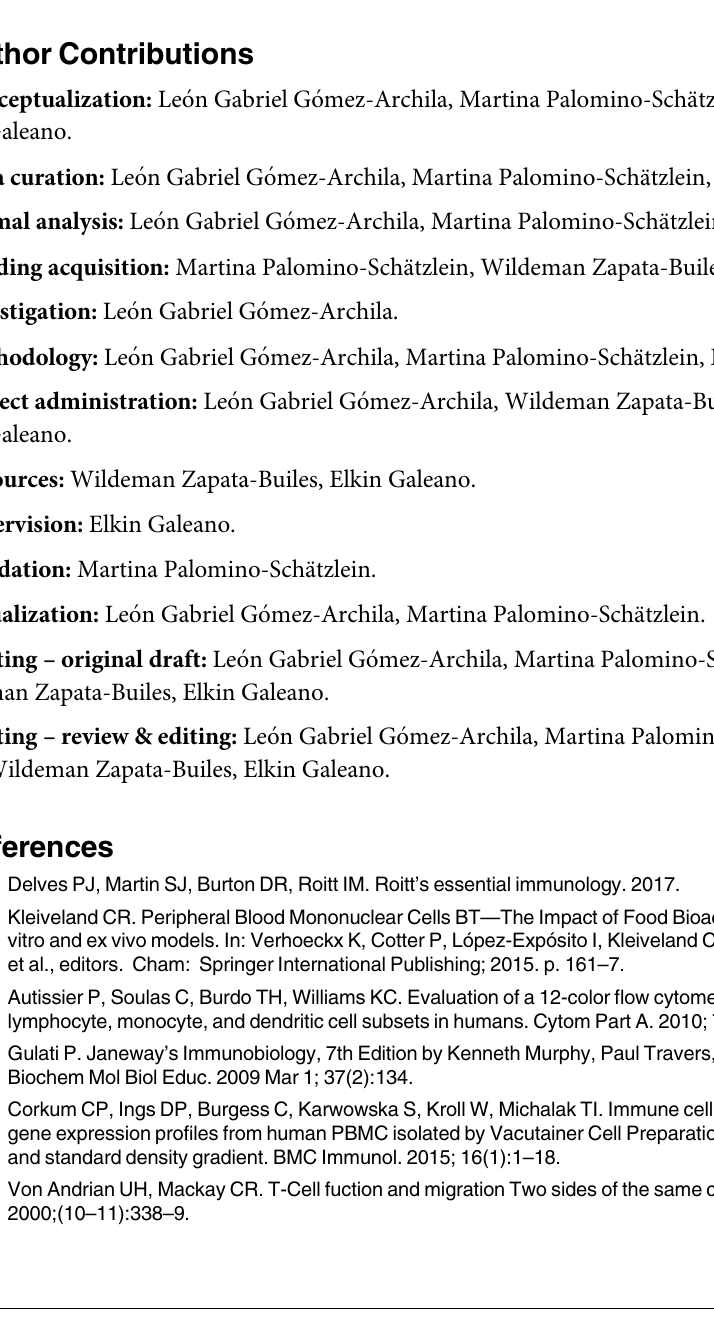
S6 Fig. Six Sigma Gage R&R Measure for Creatinine. Comparative repeatability and repro- ducibility analysis between FM, UM and UUM, for the normalized concentration of Creati- nine. S7 Fig. Six Sigma Gage R&R Measure for Creatine. Comparative repeatability and reproduc- ibility analysis between FM, UM and UUM, for the normalized concentration of Creatine. S8 Fig. Six Sigma Gage R&R Measure for Choline. Comparative repeatability and reproduc- ibility analysis between FM, UM and UUM, for the normalized concentration of